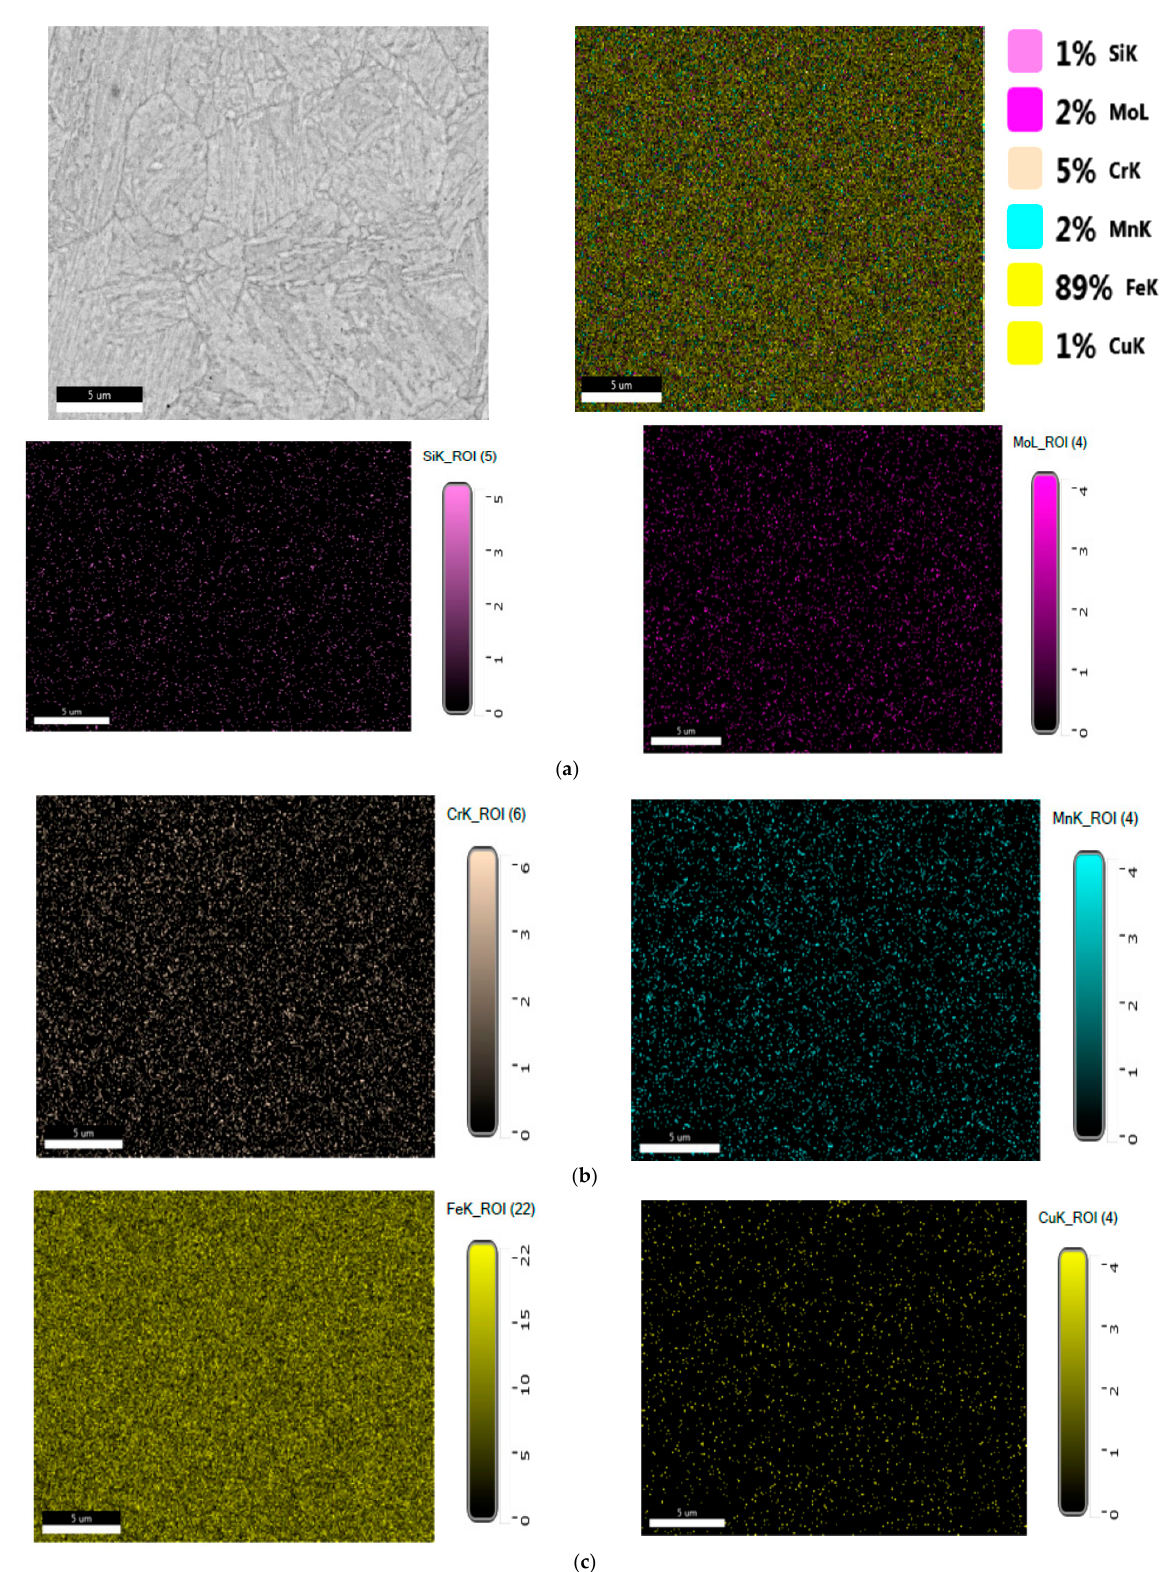
Figure 5. Electronic scanning microscopy for 10CrMo9-10 sample. Results obtained for structural investigation of energy dispersion spectrometry (EDS, are presented in Figure 6.